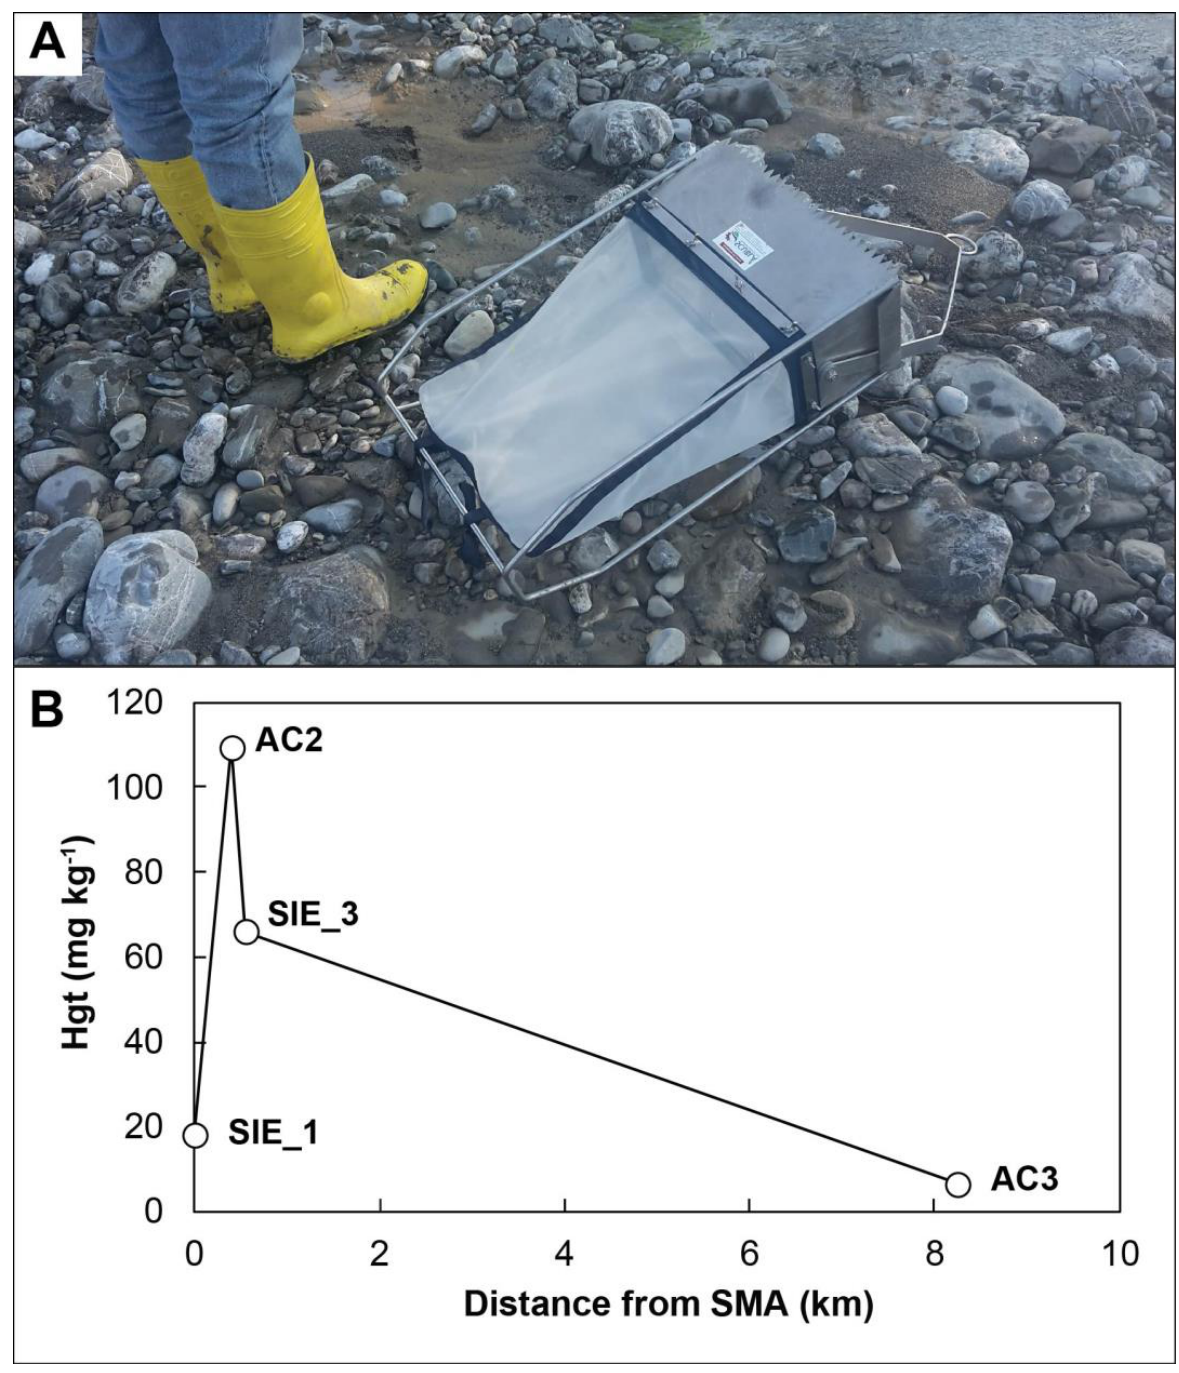
Figure 3. ( A ) Example of bedload trap (Bunte model). ( B ) Total Hg (mg kg −1 ) in bedload trap sediments vs. distance from the Siele mining area (SMA). Refer to Table 4 for the sampling periods. Along Siele Creek, in June and November 2020, Q showed an increasing trend from upstream (SIE_M) to downstream (TSIE) (Table 2). At TSIE, in June, Q was higher (139 L s − 1 ) than in November (63 L s − 1 ). Similar to Paglia River, this variability is strongly related to the precipitation regime before the sampling campaigns (Table 2). In June, the Hgt in the water upstream from the mining area (SIE_M) varied from 103 ng L −1 to 1601 ng L −1 at the exit of the SMA (SIE_V), and it was 50 ng L −1 before the confluence with Paglia River (TSIE) (Figure 2A).